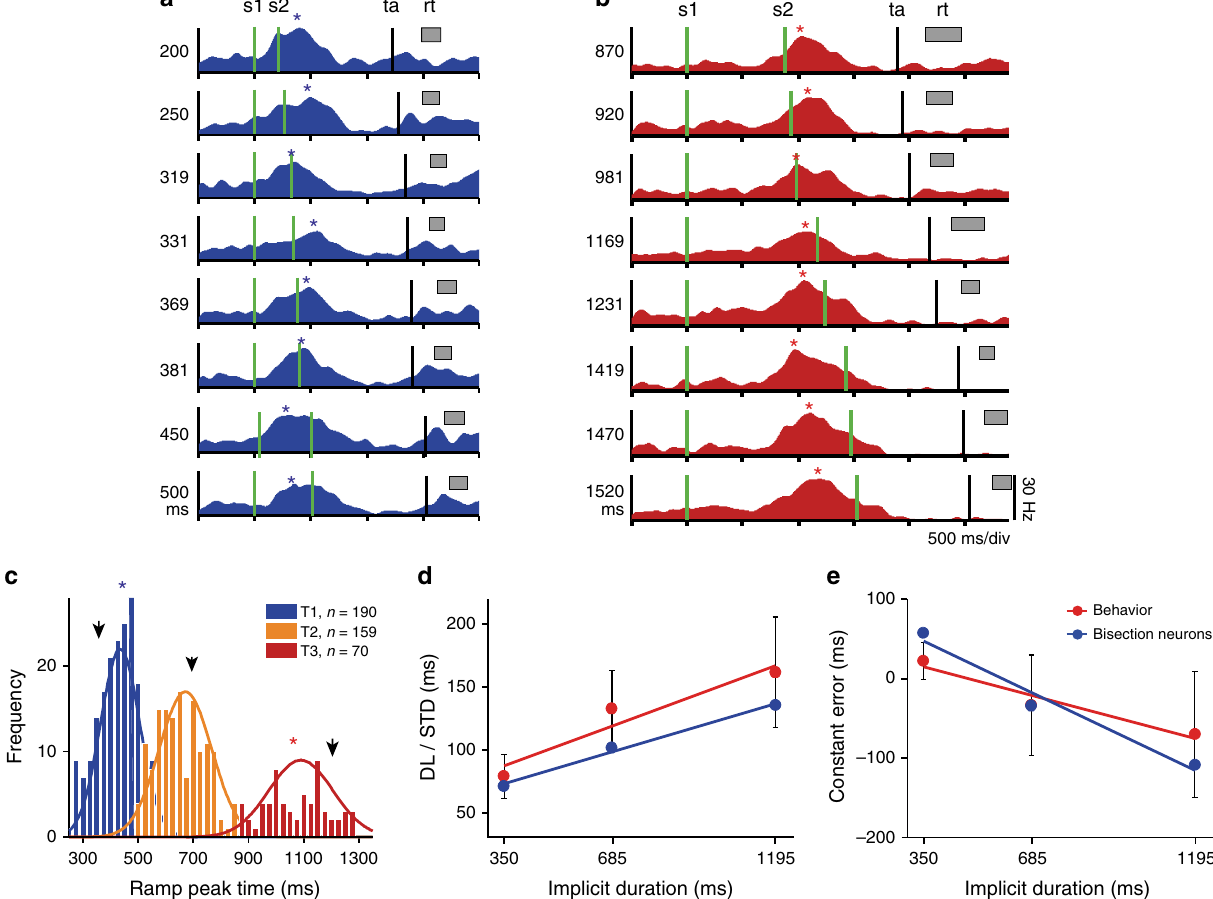
Fig. 2 ‘ Boundary ’ neurons encode the boundary between short and long categories across stimulus blocks. a Mean SDFs of a neuron for the test intervals of the T1 block. The two green vertical lines correspond to the two stimuli (s1 and s2) that de fi ne the test interval; the SDFs are aligned to the fi rst stimulus. The time of peak activity (asterisk) occurs close to the implicit limit between short and long categories for this block (350 ms). The black vertical line indicates the target presentation (ta) and the gray rectangle the standard deviation of the movement initiation (rt). b Activity of the same neuron in a but recorded in the T3 block. The peak of activity shifted to the right, close to the limit for this block (1195 ms). c Histograms and corresponding Gaussian fi ttings of the mean times of peak activity for all boundary neurons across the three blocks (see the inset for color code). Arrowheads show the location of the implicit limit for each block. Asterisks indicate the mean times of peak activity of the neuron in a , b . d DL from both monkeys (red) and the standard deviation of the Gaussian functions in c as a function of the implicit limit for the three blocks. Lines show the best linear fi ts to the data. The linear increase in temporal variability (threshold) as a function of implicit limit duration (i.e., the scalar property of interval timing) is similar to the increase in the standard deviation of the peak time distributions for boundary neurons across the three blocks. The slope and constant are 54.5 and 0.09 for the psychometric behavior, and 45.2 and 0.06 for the boundary neuron distributions (both fi ts with p < 0.05). e Comparison between the behavioral constant error (mean ± SEM) and the time difference between the mean of the Gaussian functions in c and the implicit limit for the three blocks. Both the behavioral (red) and neural measures overestimate the shortest block (T1) and underestimate the longest block